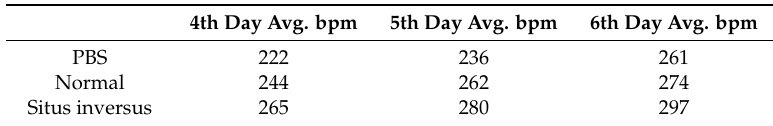
Table 1. Measurement of heart beats per minute using commercially available heart beat monitor.